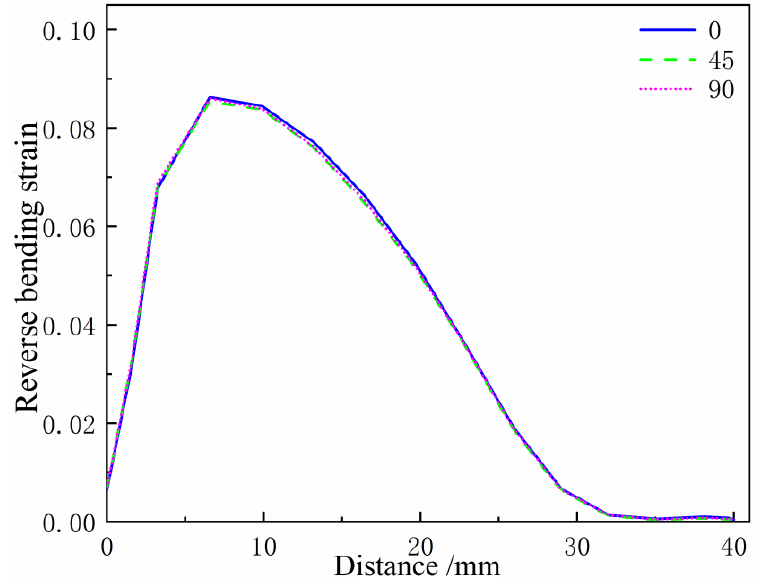
Figure 26. Reverse strain curves at different rolling directions.